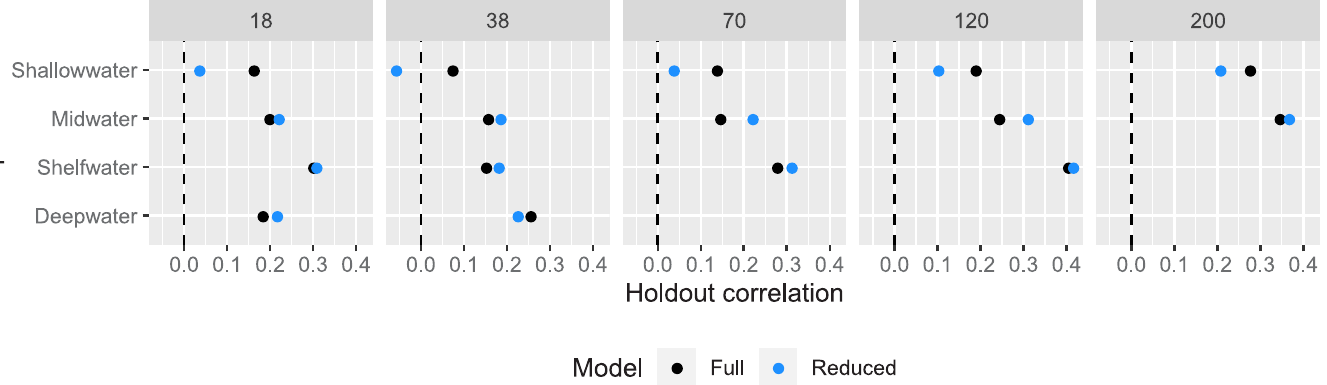
Fig 3. Withheld 2015 test set correlations. Pearson correlation coefficients between the true and predicted log NASC values in the 2015 test set, with black representing the full model and blue representing the reduced model. The x-axis represents the correlation values, and the y-axis represents depth bins. The panels represent the sonar frequency